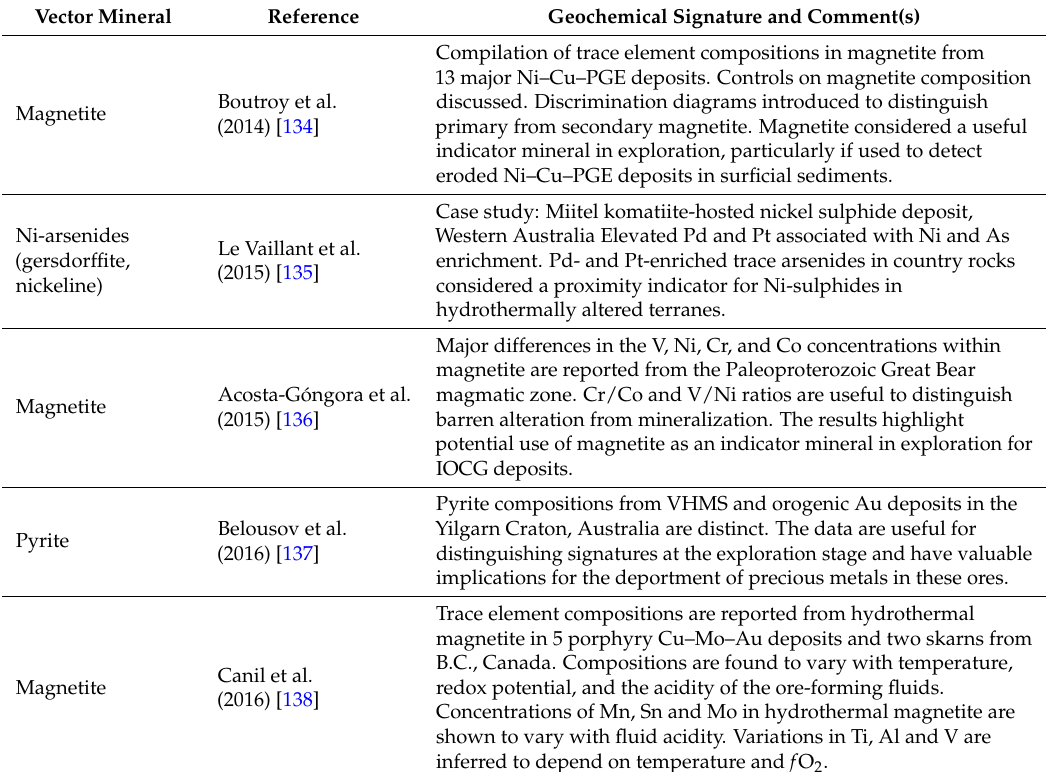
Table 4. Selected examples of LA-ICP-MS studies of minerals as indicators of proximal and distal position, or supporting a vector approach in mineral